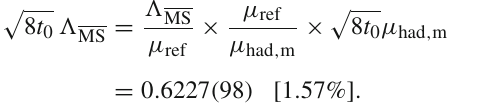
(Table5)arealsoplotted.Thesehoweverarenotusedforanycontinuum extrapolation (see main text for the details)